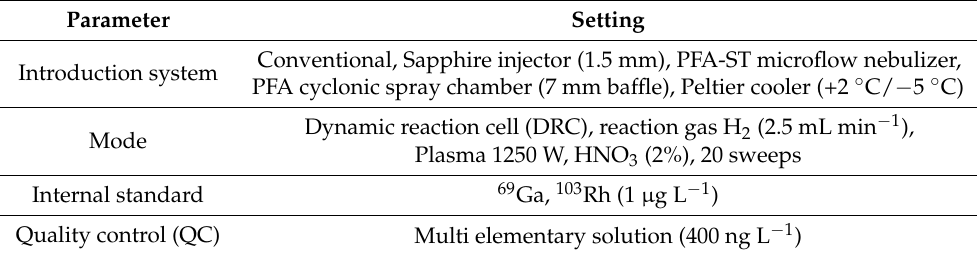
Table A4. Conditions of the ICP-MS (NexION ® 300) analysis.